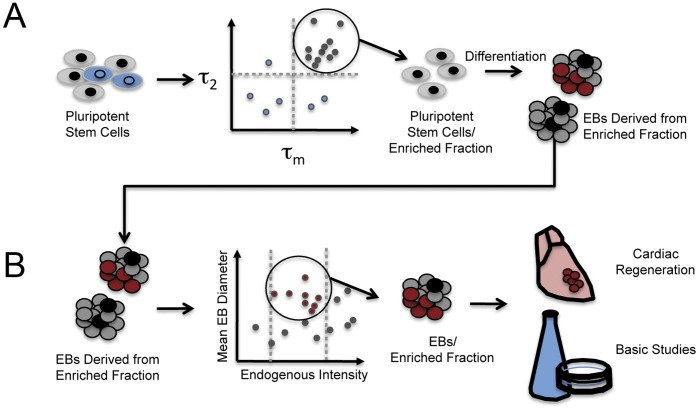
Defining signatures for non-invasive enrichment of pluripotent stem cells and associated progeny.This schematic outlines how the changes in endogenous fluorescence that occur with stem cell differentiation might be practically employed to enable both basic studies of the cues that dictate stem cell differentiation as well as clinical applications. A. Enrichment of pluripotent stem cell populations. It is difficult to maintain a pluripotent stem cell population in a culture dish as multiple stimuli can conspire to induce unwanted differentiation. Several approaches have been employed in an attempt to monitor and maintain pluripotent populations, but all are invasive in nature (i.e., exogenous labels or stably integrated antibiotic resistance genes). Instead, using a multiphoton-based flow cytometry system [5], threshold values (dashed lines) for intrinsic fluorescence lifetime elements might be identified and utilized to enrich populations. The cellular-scale analyses described here are particularly well suited to define threshold values. Stem cells enriched in this way could be used for a variety of applications, including the generation of EBs. B. Enrichment of EBs. EBs have long served as a developmentally-relevant format for inducing stem cell differentiation. The challenge is isolating EBs that give rise to particular differentiated cell types in an enhanced-throughput, noninvasive manner. Here we suggest use of parameters from our global-scale analyses, such as endogenous fluorescence intensity, to define thresholds that might be used to purify EBs at early time points that have a high probability of generating differentiated cell types of interest, such as cardiomyocytes. Differentiated cells enriched in this way would be quite valuable for basic studies of the cues that drive differentiation and perhaps, in the future, for regenerative therapies.